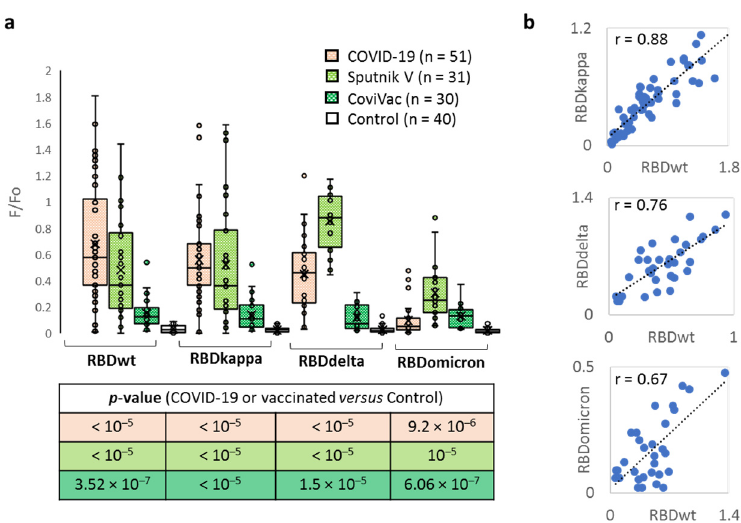
Figure 4. Microarray application for the analysis of inter ‐ strain cross ‐ reactivity. ( a ) Responses of convalescent (COVID ‐ 19) and vaccinated donors to RBDs of different SARS ‐ CoV ‐ 2 variants; ( b ) Correlation between the levels of Abs against RBD of different SARS ‐ CoV ‐ 2 variants.